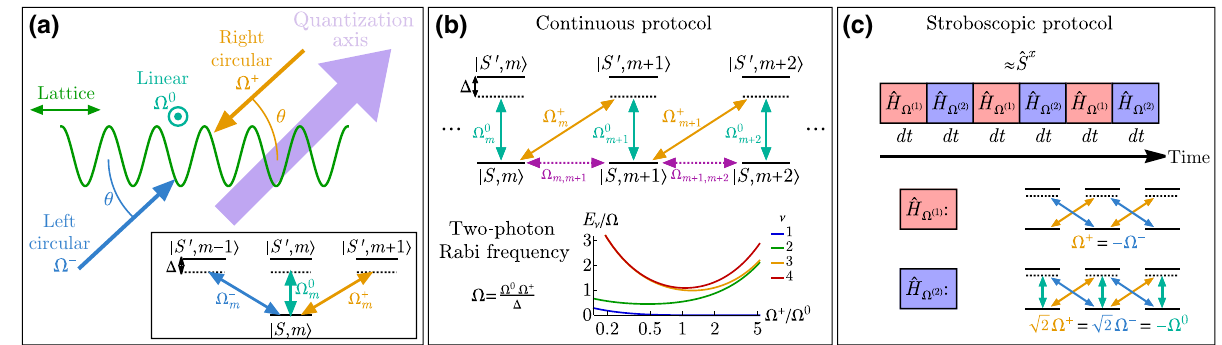
FIG. 10. (a) General schematic for realizing the SU ( n ) system using a Raman coupling in a lattice with alkaline-earth atoms. Far- detuned Raman beams with different polarizations illuminate the lattice. The one-photon couplings (cid:2) 0 Clebsch-Gordan coefficients, but proportional to overall magnitudes (cid:2) 0 , (cid:2) ± . The linearly polarized (cid:2) 0 beam propagates perpendicular to the lattice direction, while the right- and left-circular beams (cid:2) + , (cid:2) − point in equal and opposite directions at an angle θ to the lattice direction. (b) Protocol for generating a “nearest-neighbor” drive coupling along the synthetic dimension. The linear and right-circular beams are used to realize effective two-photon couplings (cid:2) m , m + 1 . The overall intensity of the couplings is set by (cid:2) = (cid:2) 0 (cid:2) + /(cid:10) . The bottom plot shows the energies of the onsite drive eigenstates as a function of (cid:2) + /(cid:2) 0 , demonstrating that the dressed state spectrum can be tuned. (c) Protocol for generating a spin- S stroboscopically alternated. They realize effective drives of ( stroboscopic rate is faster than the tunneling and